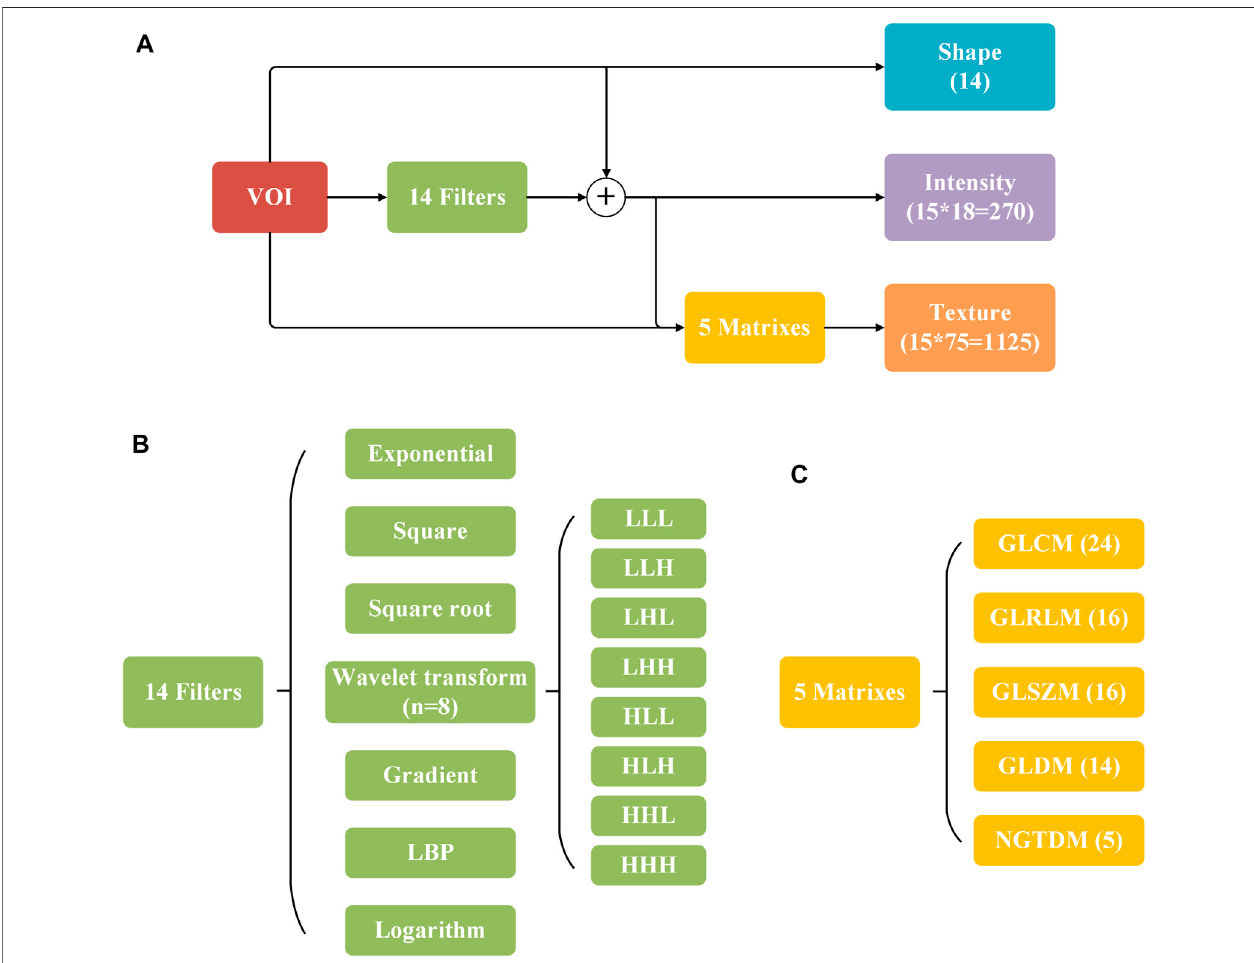
FIGURE 2 | Description of 1,409 radiomics features. (A) Process of feature extraction. (B,C) 14 fi lters and fi ve matrixes used in (A) . The numbers of extracted features are indicated in parentheses.